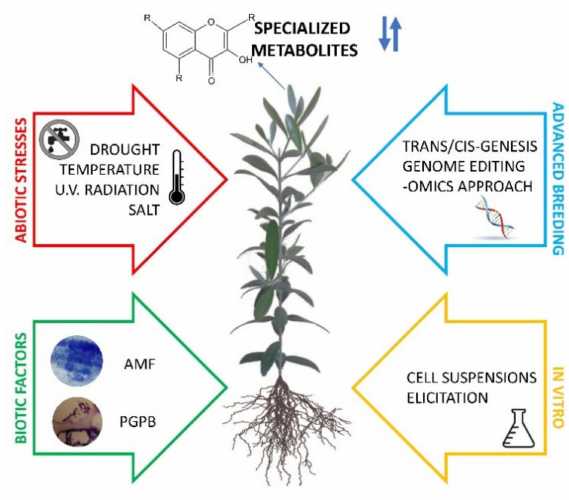
Figure 1. Scheme representing the diverse factors (natural, on the left, and artificial, on the right part) that can modulate specialized metabolites in plants: abiotic stresses as drought, salt, UV radiation and temperature; microorganisms (i.e., biotic factors) such as plant growth-promoting bacteria—PGPB and arbuscular mycorrhizal fungi—AMF; in vitro systems; advanced breeding techniques based on trans/cis-genesis, genome editing and -omics